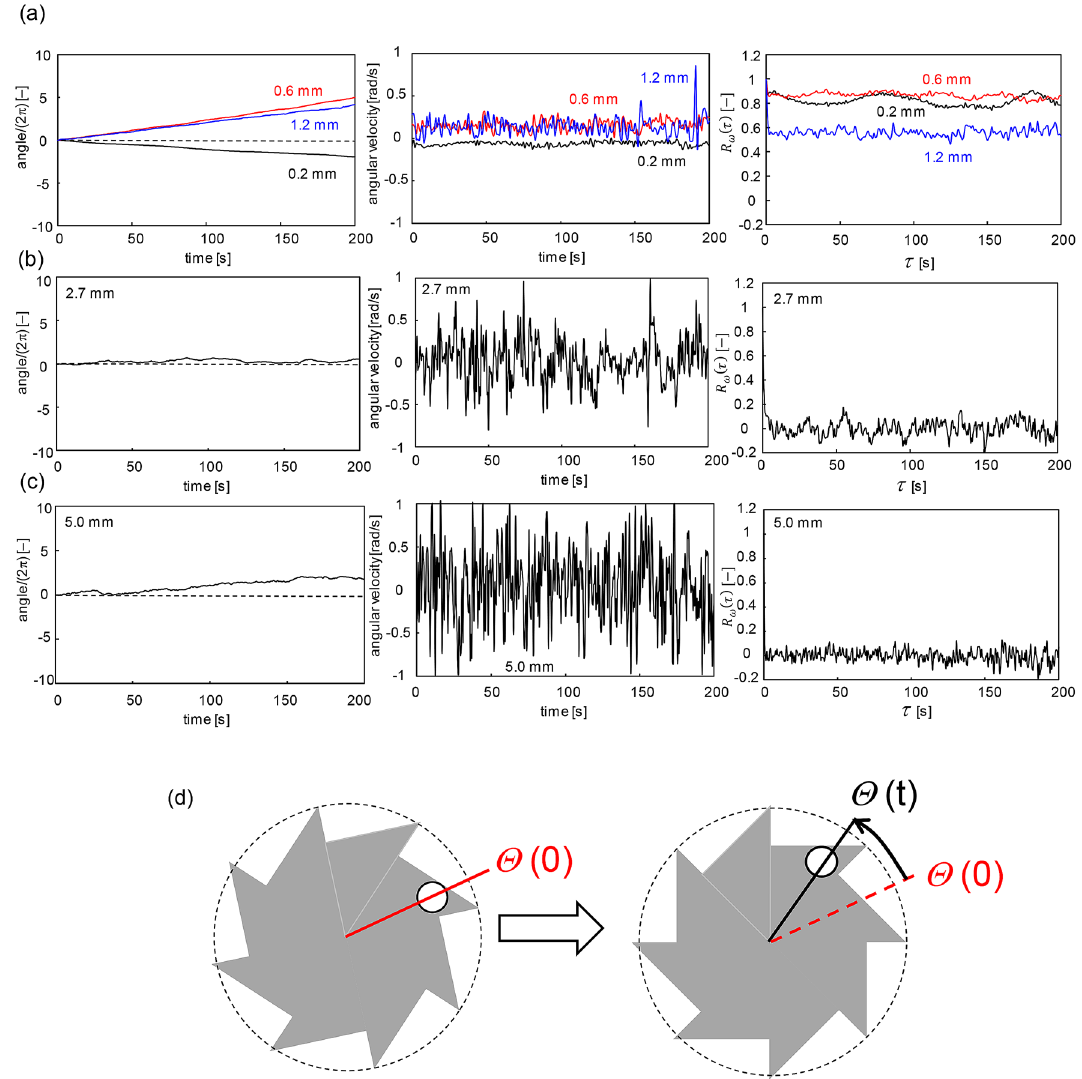
Figure 3. Characteristics of gear motion with constraint condition: azimuth change, angular velocity, and autocorrelation function for bead diameters of ( a ) 0.6–1.2 mm, ( b ) 2.7 mm, and ( c ) 5.0 mm. ( d ) Definition of azimuth change Θ